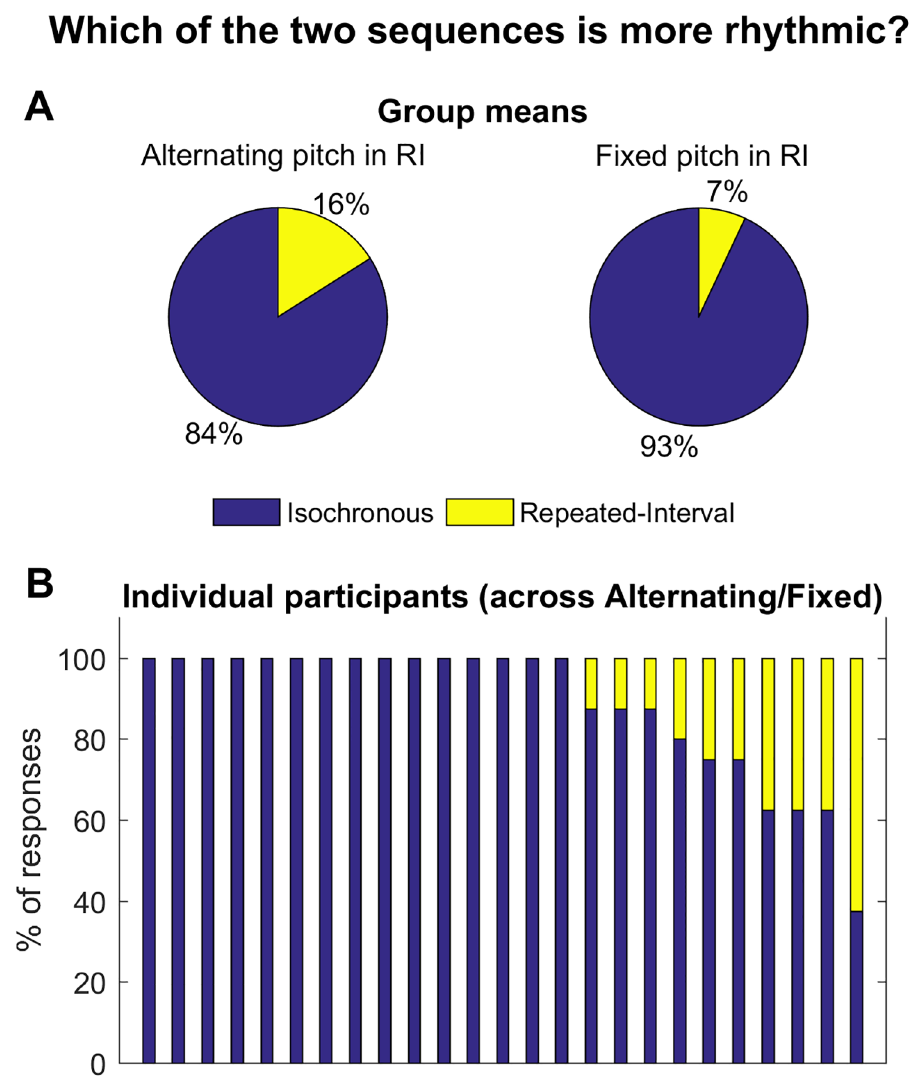
Fig 1. Testing the perceived relative rhythmicity of isochronous and repeated-interval stimulus sequences. Followingthe suggestionof OHL [4] to test subjectiverhythmicity using auditorystimulation,25 humanparticipantsperformed a 2-alternative forced-choice onlineexperimentin which they judgedwhich of 2 auditorystreams soundedmore rhythmic. The procedures of this study adheredto the guidelinesof the Declaration of Helsinki and were approved by local Ethics Committee of the HebrewUniversity of Jerusalem, Israel. (A) Mean distributionof judgments across the group. In each trial ( n = 8), participantswere presented with 2 auditory streams: one isochronous, imitatingthe sequencesof the isochronouscondition(IsoC) in [3], and the other non-isochronous, imitating one of the sequencesof the repeated-interval condition(RIC) in [3], with different inter-pairjittered intervalsin each trial. In each trial, the stimulus onset asynchrony(SOA) of the predictable interval in both sequenceswere either short (700 ms) or long (1,300 ms). In 4 trials, the stimuli of the RIC conditionalternated in pitch, reflecting the alternatingcolors in [3], while in the other 4 trials the pitch was fixed to prevent the pitch alternationfrom labelingthe RIC condition. The order of conditions (IsoC/RIC) and trial SOA were also counterbalanced, and these 3 factors were orthogonalized. Trials were presented in a randomorder, different for each participant. After presentation of the 2 sequences,participantsindicated which stream soundedmore rhythmic using the mouse or keyboard buttons, with no time pressure (see S1 Data for full dataset; see www.soscisurvey.de/abrhythms for exact instructions and full experiment). Participants providedinformedconsent by agreeingto proceedfrom the first informationscreen, and all data were analyzedanonymously.The results show a strong bias towards classifying the IsoC as “more rhythmic” ( t test comparing percentageof choosingthe isochronous as more rhythmic, across all conditions, relativeto a null value of 0.5: t (24) = 11.3, p = 5 × 10 − 11 ). (B) Response distributionsof individualparticipants. Twenty-four out of 25 participantschose the IsoC in more than 50% of the trials. Abbreviations: IsoC,